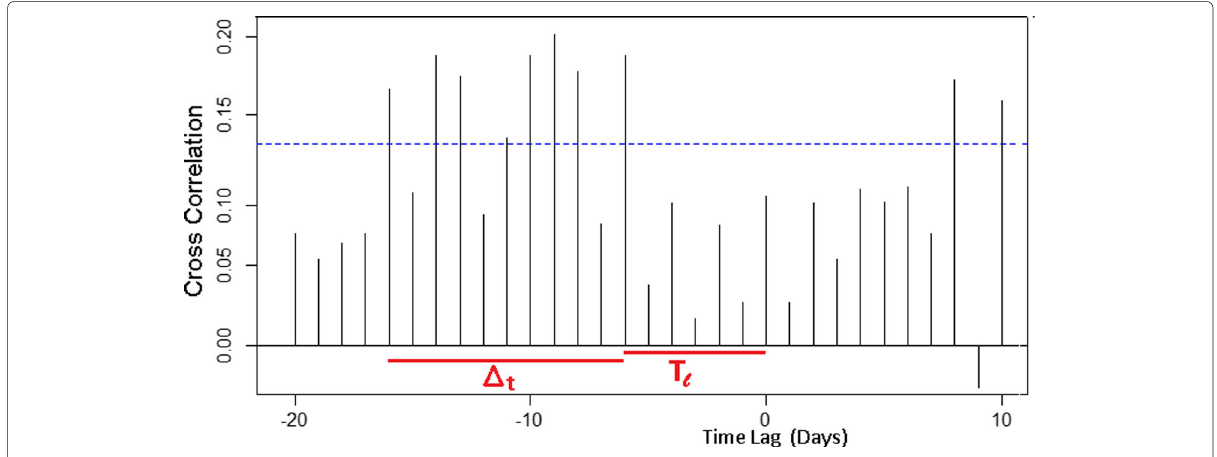
Fig. 3 An example of how cross correlation is used to find (cid:3) t and T l